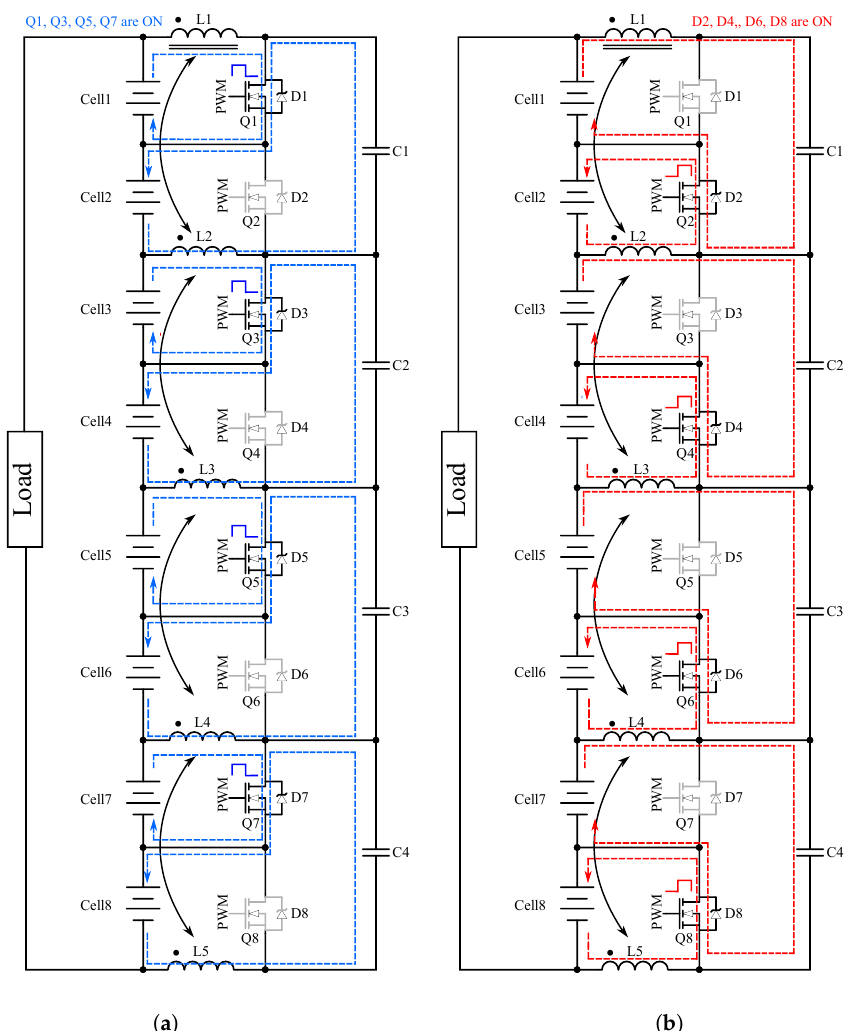
Figure 9. ( a ) The operational principle in the first mode; and ( b ) the operational principle in the second